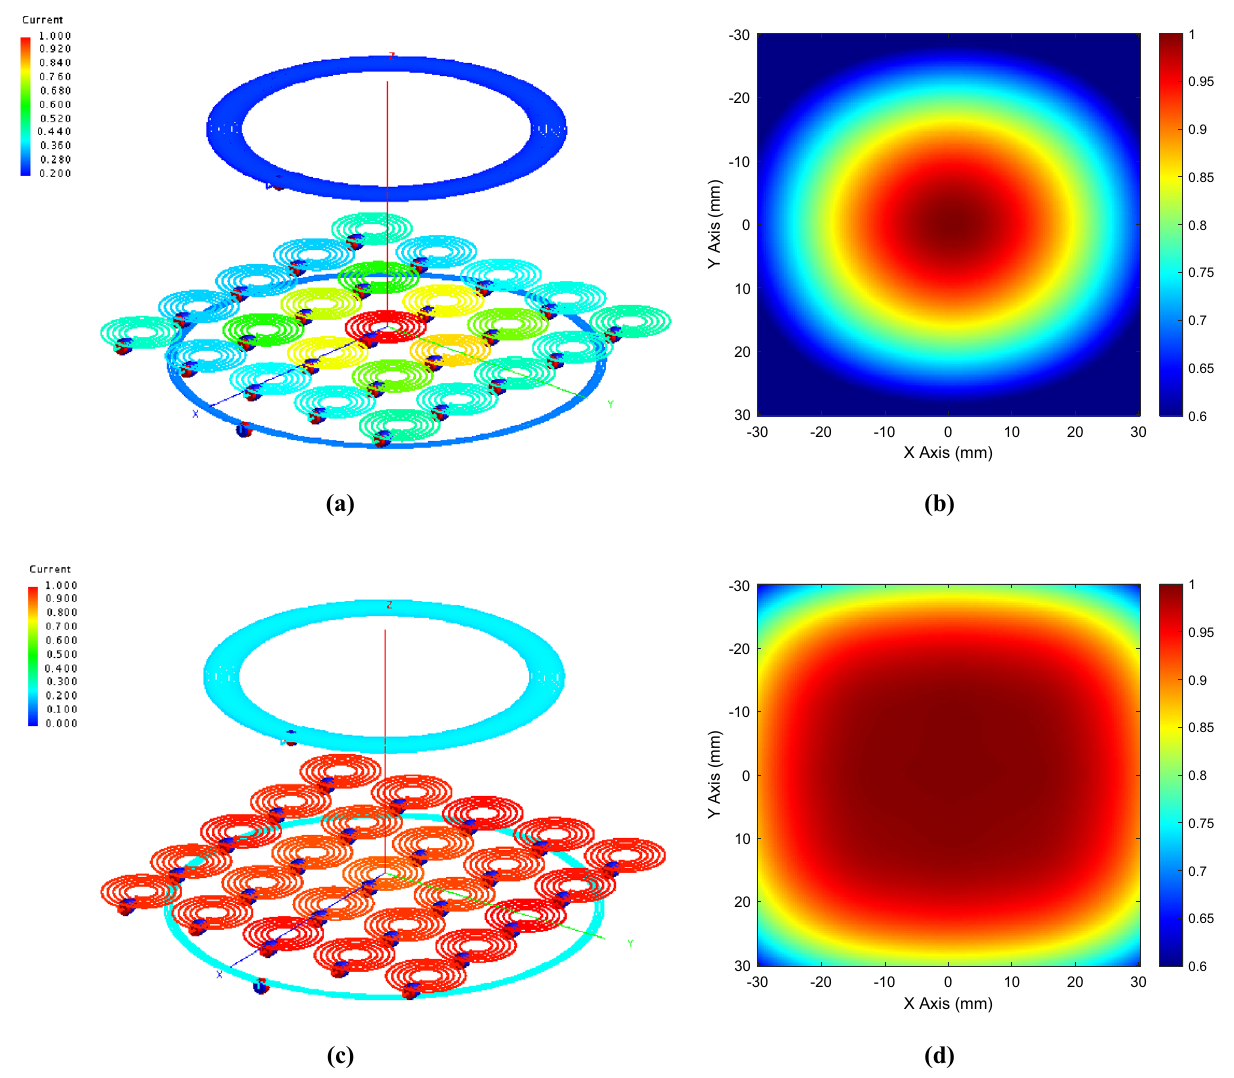
Figure 6. Normalized current distribution within the metasurface elements obtained from a full-wave simulation and corresponding normalized magnetic field at a plane 2 cm away from the metasurface. ( a , b ) Standard case : since all the unit-cells are loaded with the same capacitors, truncation effects are evident; ( c , d ) Homogenized case : when the unit-cells are loaded with the proper capacitor to achieve homogenization, the truncation effects are canceled and a more uniform field distribution is